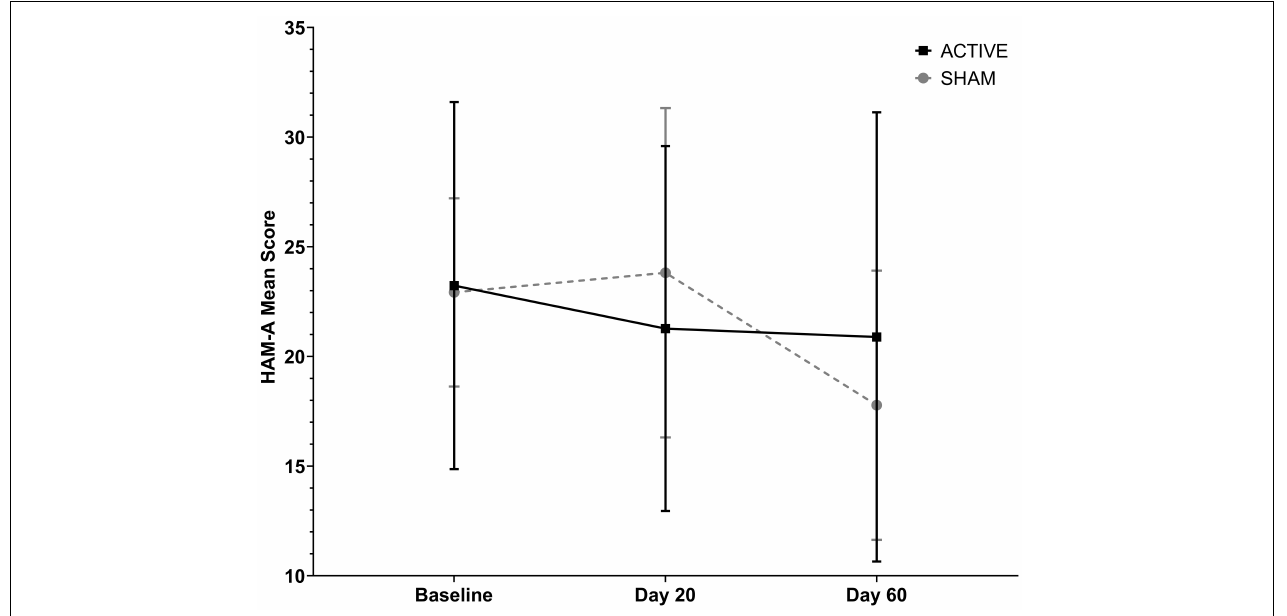
FIGURE 4 | Anxiety symptoms assessed in the active tDCS and Sham groups using the Hamilton Anxiety Scale (HAM-A) in three stages: (i) pre-treatment; (ii) after 20 daily sessions; (iii) after 1 month of follow-up, performing tDCS once a week for 3 weeks. Data are reported as mean + SD. Data analysis was performed using the Generalized Estimation Equations (GEE) model. There was no statistically significant difference between groups considering the type of